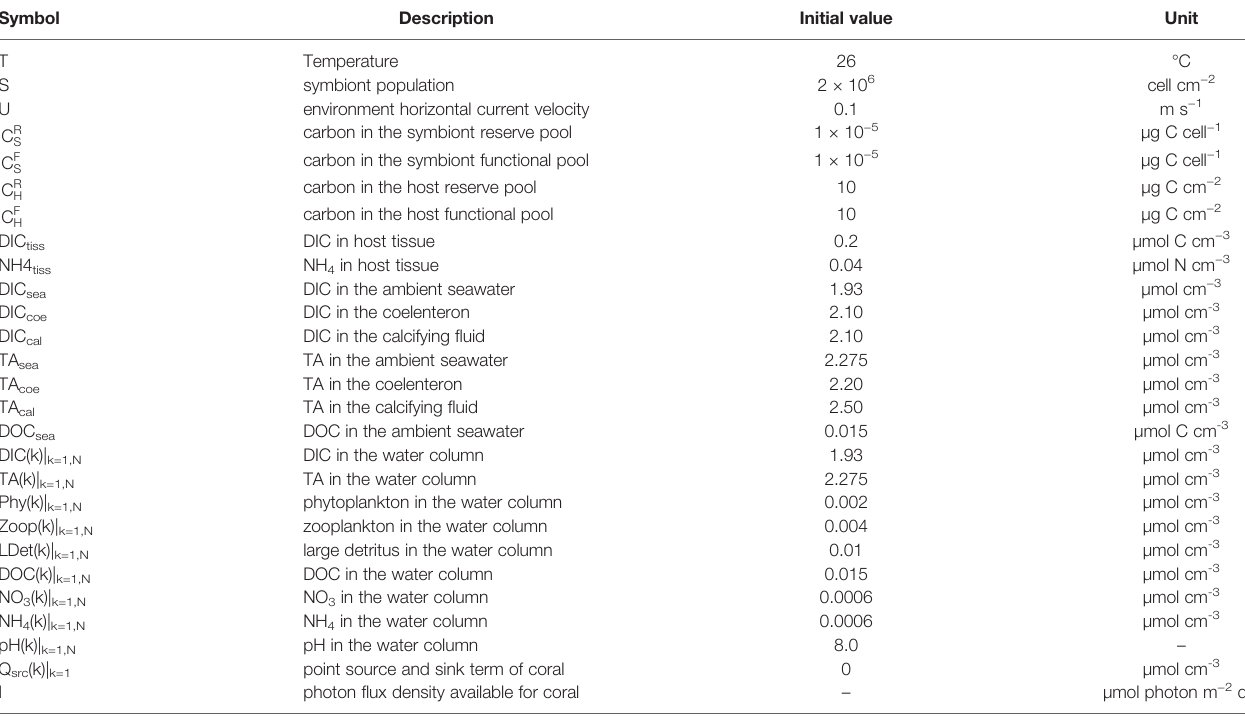
TABLE 1 | Main model state variables and initial values.